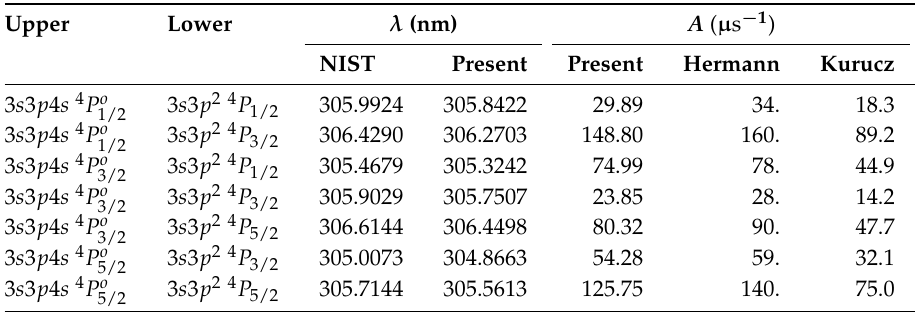
Table 5. Comparison of the transition rates computed from valence correlation calculations (present) and observed wavelengths (in a vacuum) from NIST [4,7] with observed rates from Hermann et al. [1] and values reported by Kurucz and Peytremann [2] Upper Lower λ (nm) A ( µ s − 1 ) NIST Present Present Hermann